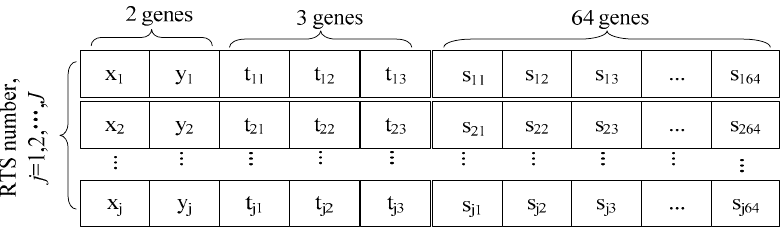
Figure 2. A basic structure of the chromosome.